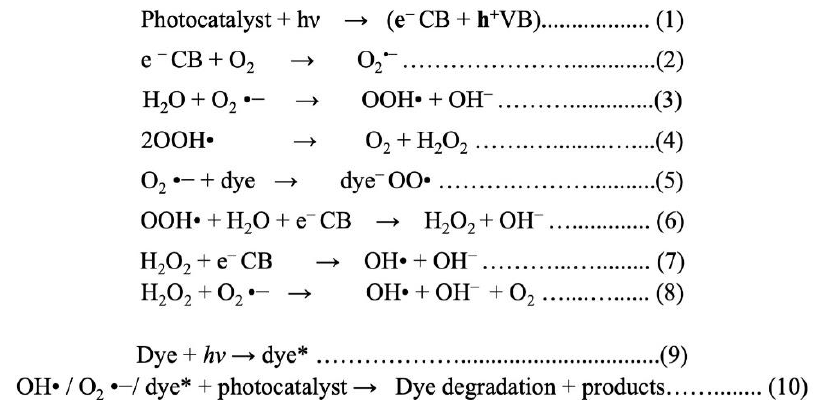
Scheme 1. Reaction scheme for the degradation of dyes using TiO 2 [90].